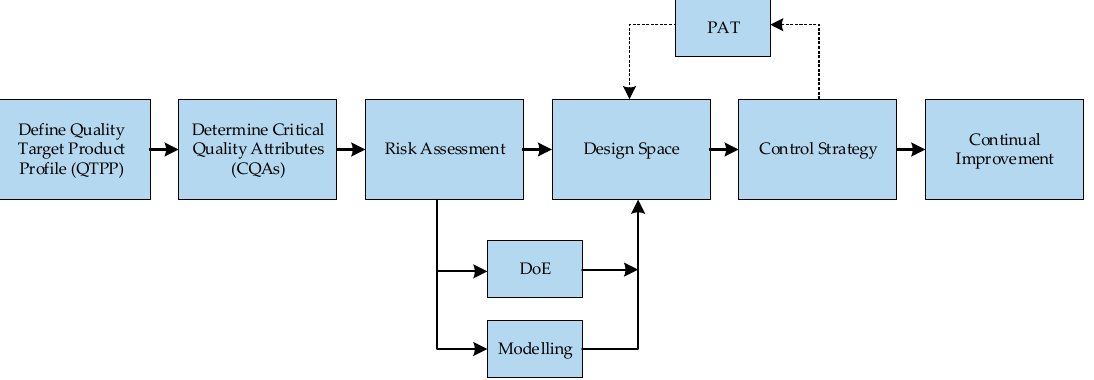
Figure 1. Quality by design approach [13]. PAT, Process Analytical Technology; DoE, design of experiments.